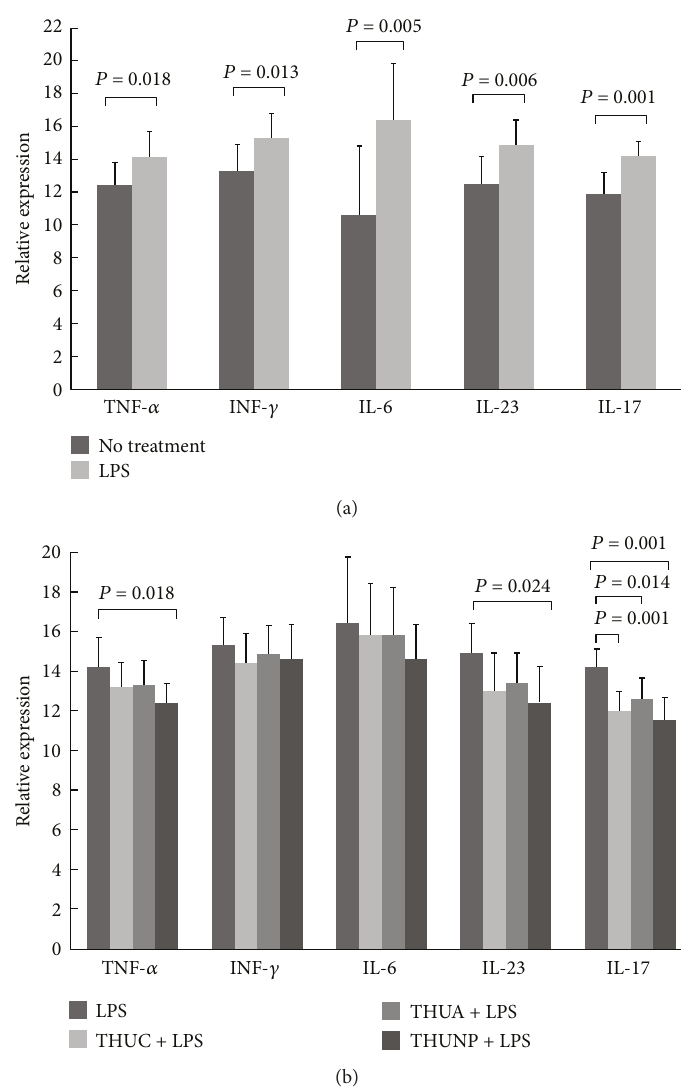
Figure 4: The e ff ects of treatment with THUC, THUA, or THUNP on the production of proin fl ammatory cytokine mRNAs in PBMCs isolated from AS patients in response to LPS. The suitable primers were synthesized as described [40]. Relative expression levels of mRNA were de fi ned by the following equation: (40 − threshold cycle [Ct] after adjustment by the expression of 18S rRNA). (a) Treatment with LPS promotes the mRNA expression of cytokines, TNF- α , INF- γ , IL-6, IL-23, and IL-17A mRNAs (mean ± SD, n = 9 ). P values were obtained by t -test. (b) Treatment with THUC, THUA, or THUNP reduced the expression of IL-17A mRNA. Treatment with THUNP also suppressed the expression of TNF- α and IL-23 mRNAs (mean ± SD, n = 9 ). P values were obtained by one-way analysis of variance test followed by Sidak multiple comparison